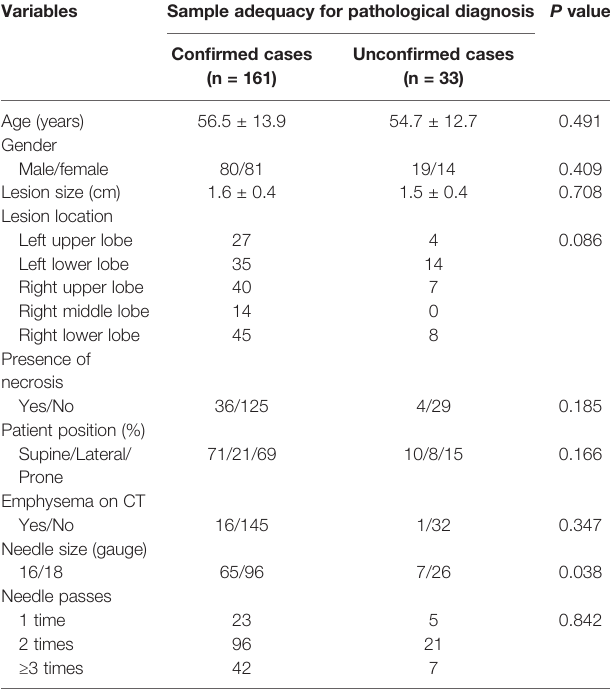
TABLE 3 | Univariate analysis of in fl uence factors for sample adequacy of ultrasound-guided percutaneous core needle biopsy for PPLs ≤ 2 cm.